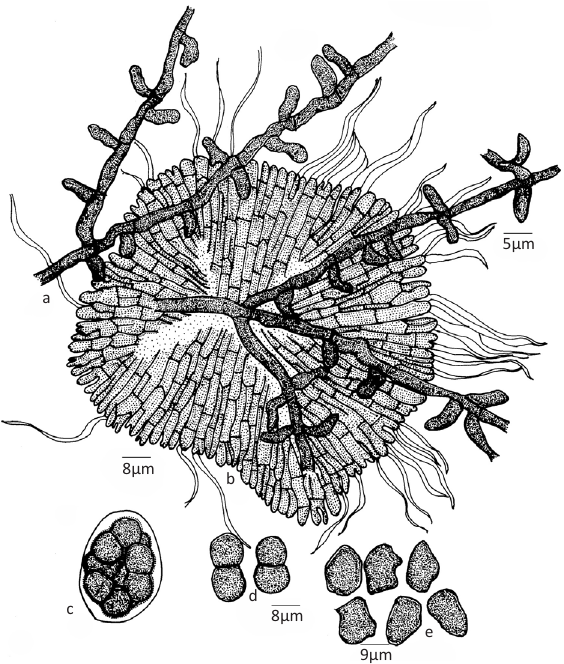
Figure 1. Asterina arkemibeyi sp. nov. a - Appressoriate mycelium; b - Thyriothecium; c - Ascus; d - Ascospores; e -